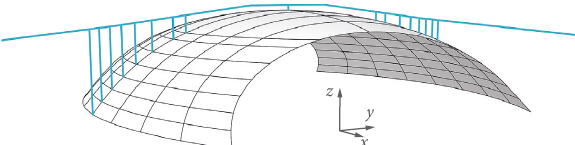
Figure 16: Illustration of the soil cover